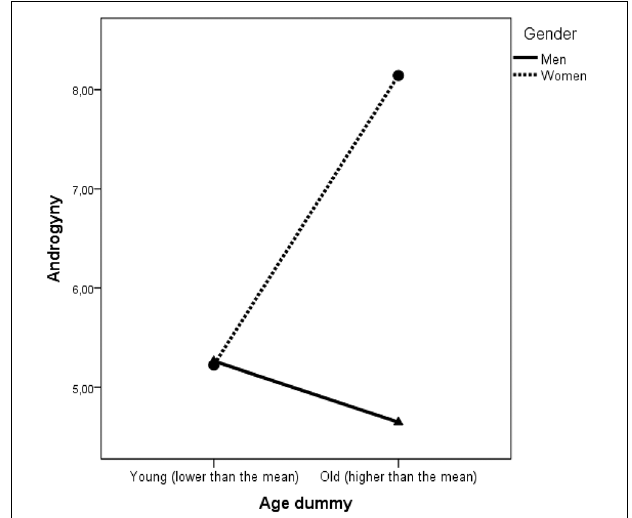
FIGURE 6 | The interaction effect between age and gender on